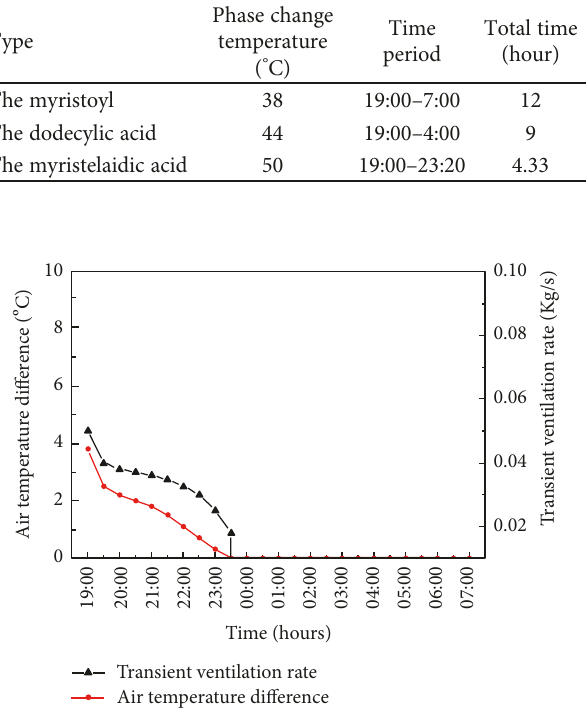
Figure 7: Variation of air temperature and ventilation rate for phase change temperature of 50 °